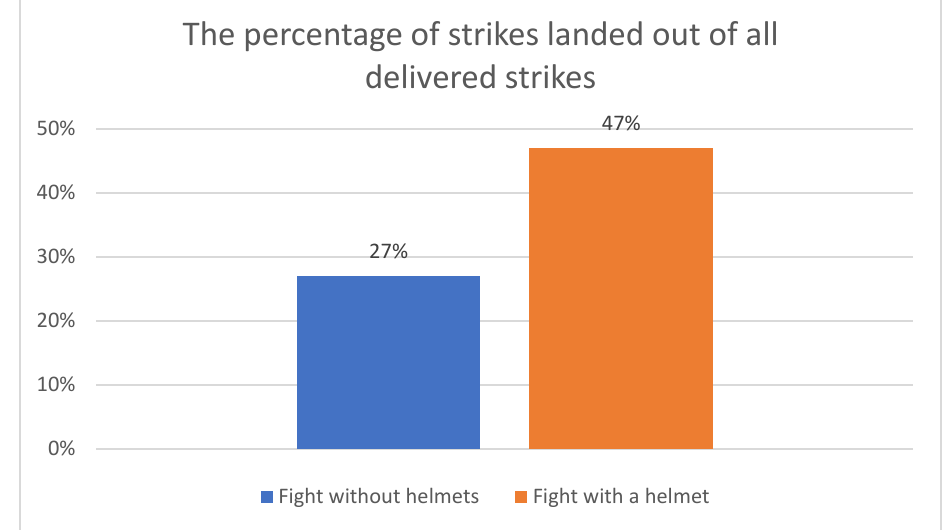
Figure 2. The percentage of strikes landed out of all delivered strikes.